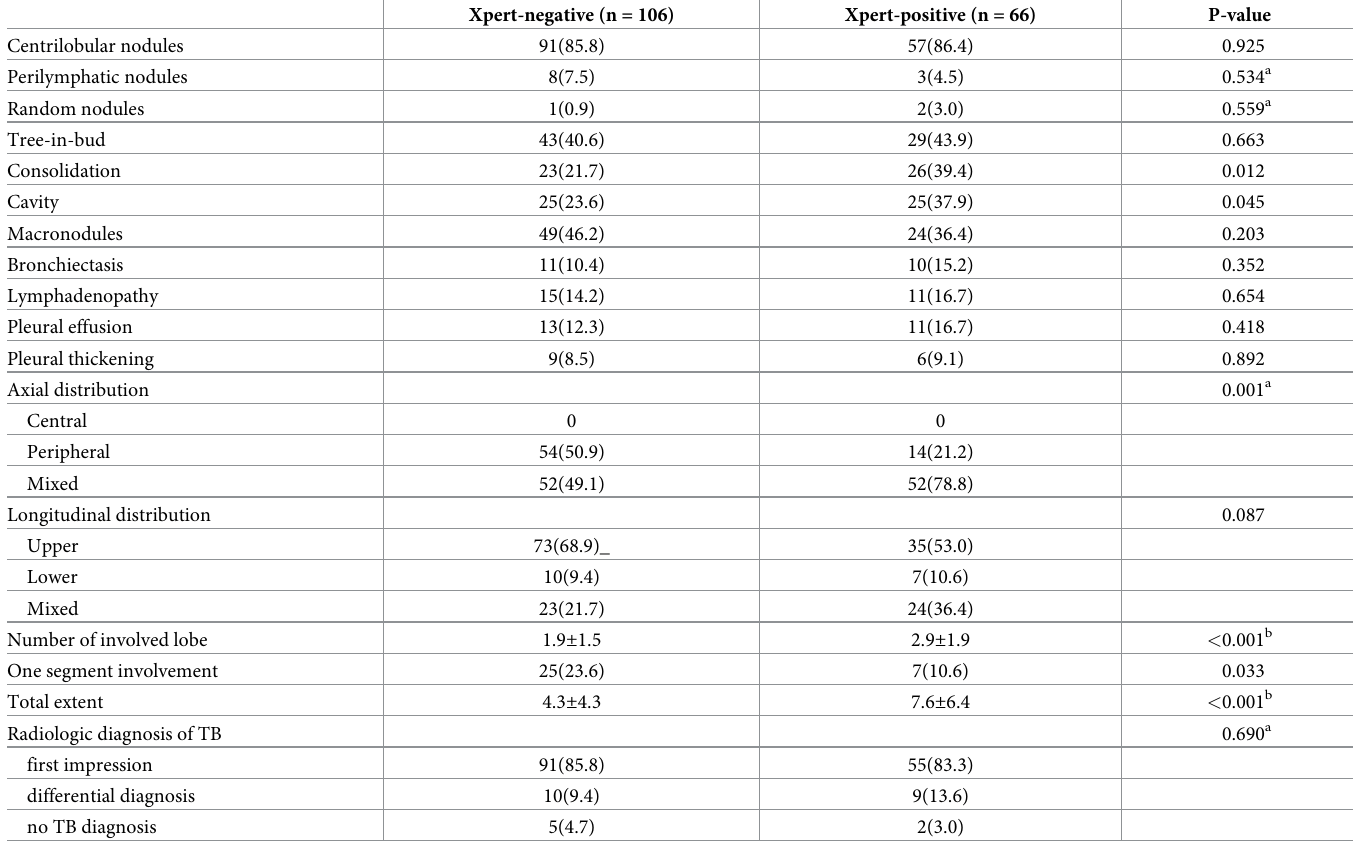
Table 3. Comparison of chest CT findings between Xpert MTB/RIF negative and